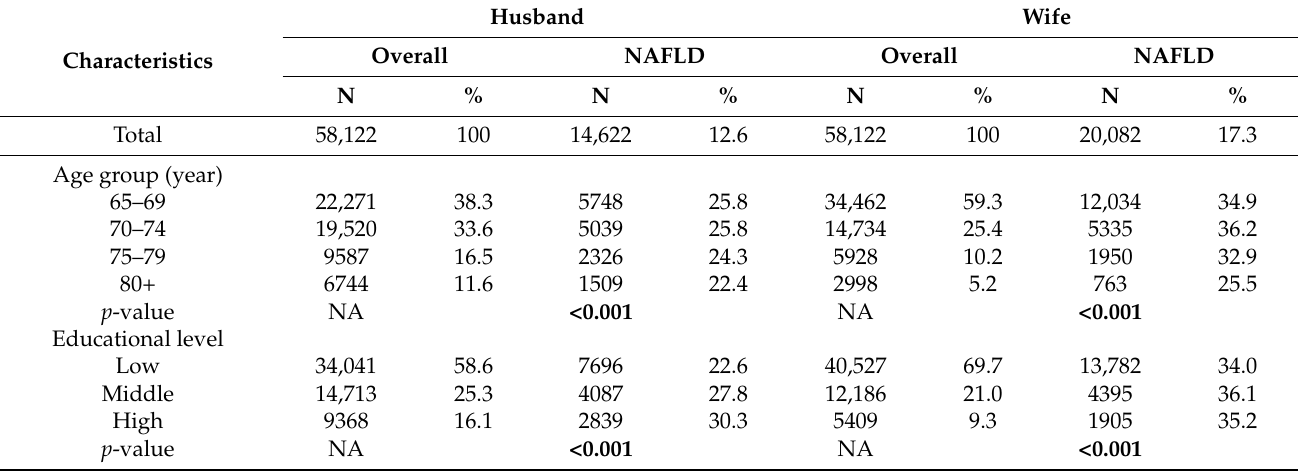
Table 1. Characteristics of the study participants categorized by gender (husband and